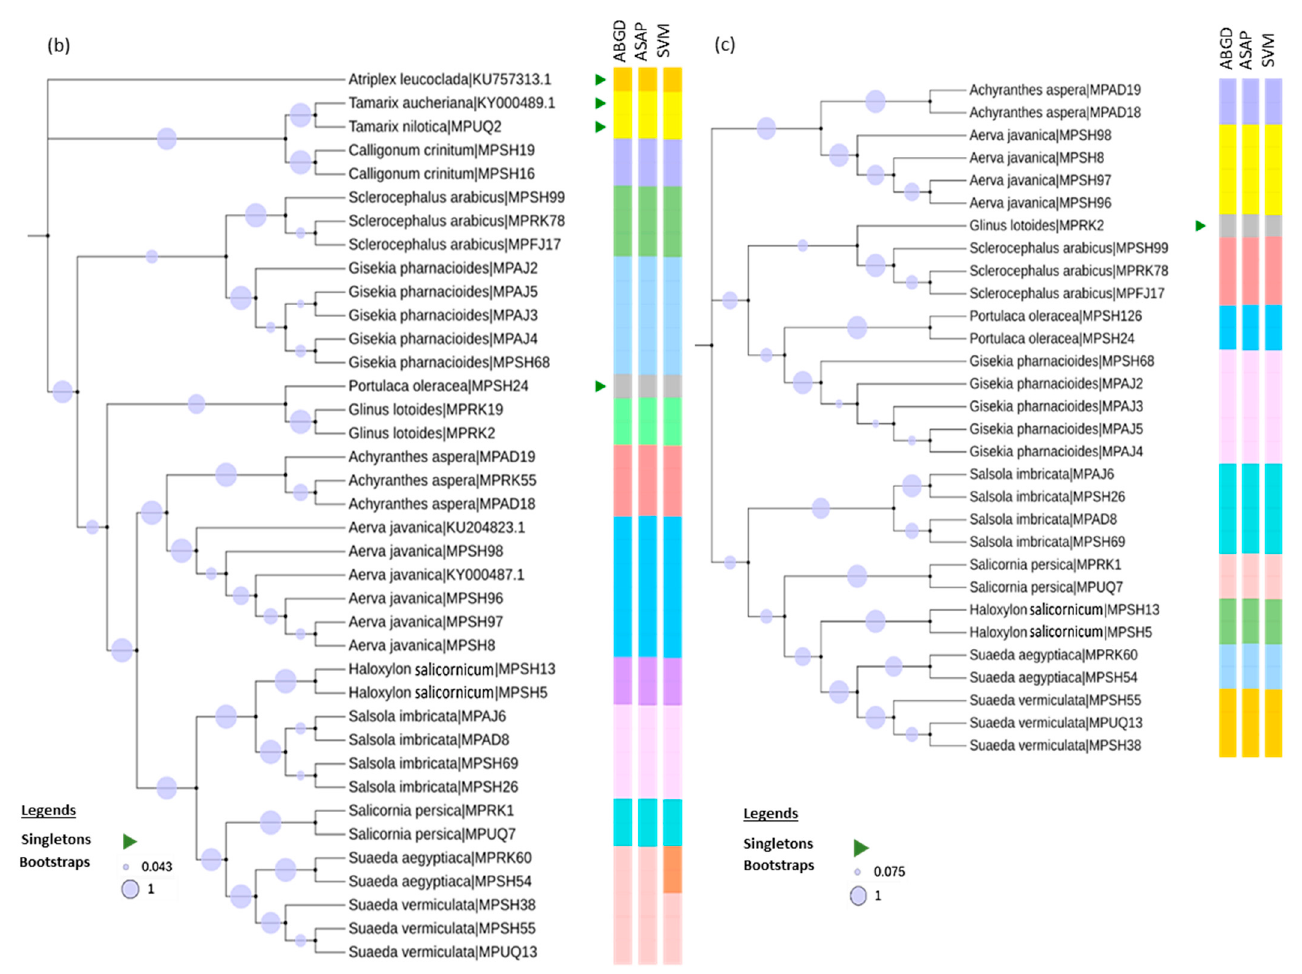
Figure 3. Taxonomic evaluation using unsupervised (ABGD and ASAP) and supervised learning